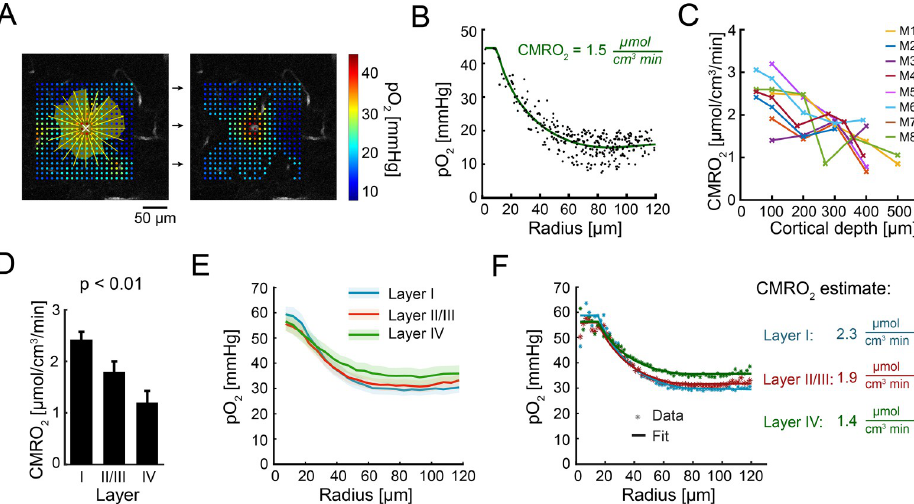
Fig 3. Cerebral metabolic rate of O 2 (CMRO 2 ) estimation across cortical layers. (A) An imaging plane 100 μ m below the surface; a grid of partial pressure of O 2 (pO 2 ) points is overlaid on the vascular image. pO 2 values were interpolated along the radial yellow lines. The yellow shaded area extends along each direction until the first derivative becomes 0. The segmented region of interest (ROI) used for extraction of the radial pO 2 profile is shown on the right. This ROI also includes values within the low tail of the pO 2 distribution. (B) The radial pO 2 profile extracted from (A). The ODACITI fit is overlaid on the data. The fitted CMRO 2 value is 1.5 μ mol cm − 3 min − 1 . (C) Estimated CMRO 2 for the entire dataset of 51 planes along 11 diving arterioles in 8 subjects. Measurements along the same arteriole are connected with a line. Subjects are color-coded. (D) Quantification of CMRO 2 across layers using the data in (C). Error bars show standard error calculated using a linear mixed effects model implemented in R. (E) Experimentally measured tissue pO 2 (mean ± SEM, binned at 5 μ m) across cortical layers (color-coded) as a function of distance from the arteriole. Each profile represents a grand average across subjects. (F) ODACITI fit for the data shown in (E) (binned at 2 μ m). Numerical values for (B–F) are provided in S1 Data (sheets